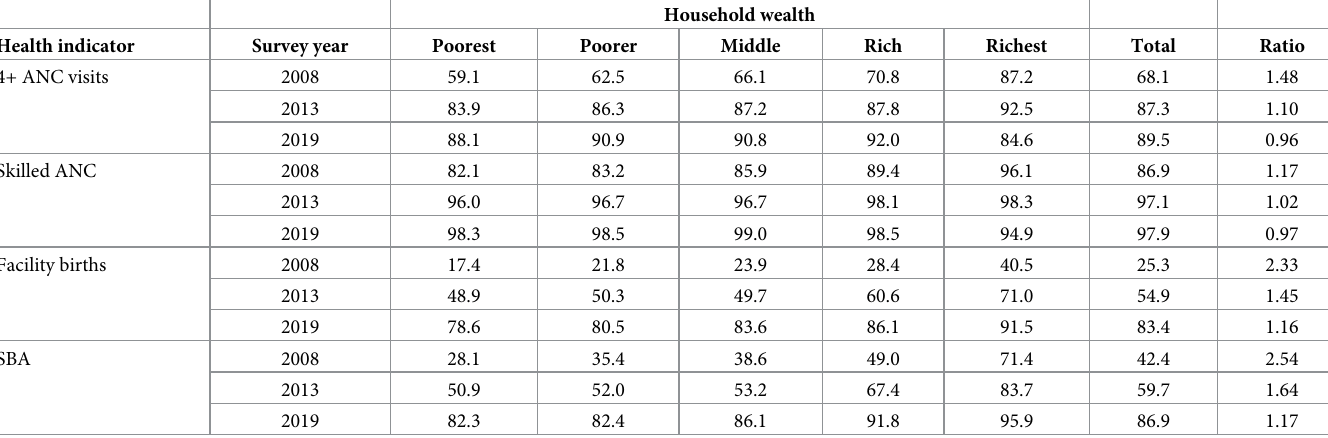
Table 3. Maternal health indicators by household wealth quintile in 2008, 2013 and 2019.